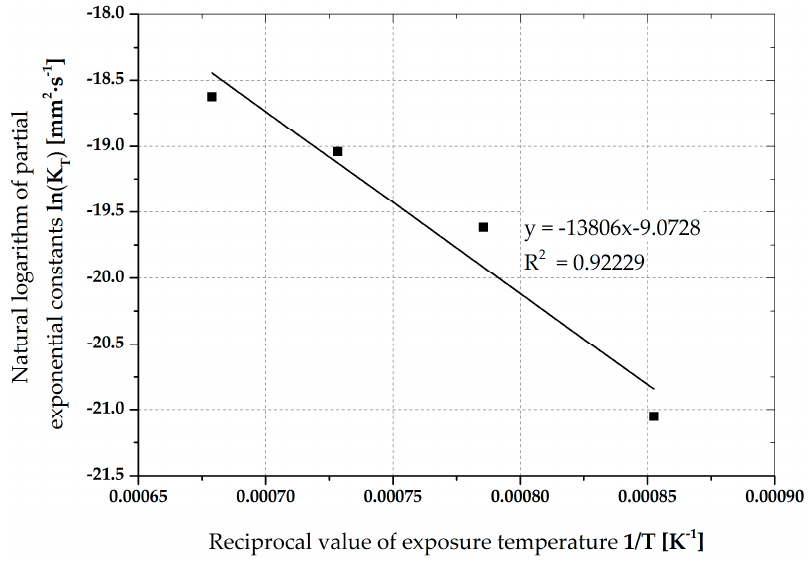
Figure 4. Determination the total exponential constant K 0 and the grain growth activation energy Q . Using the trend line data (Figure 4) and Equations (7) and (8), the activation energy of grain growth Q = 264.02 kJ·mol − 1 and proportionality constants K 0 = 11.47 × 10 − 5 (mm 2 ·s − 1 ) were obtained for